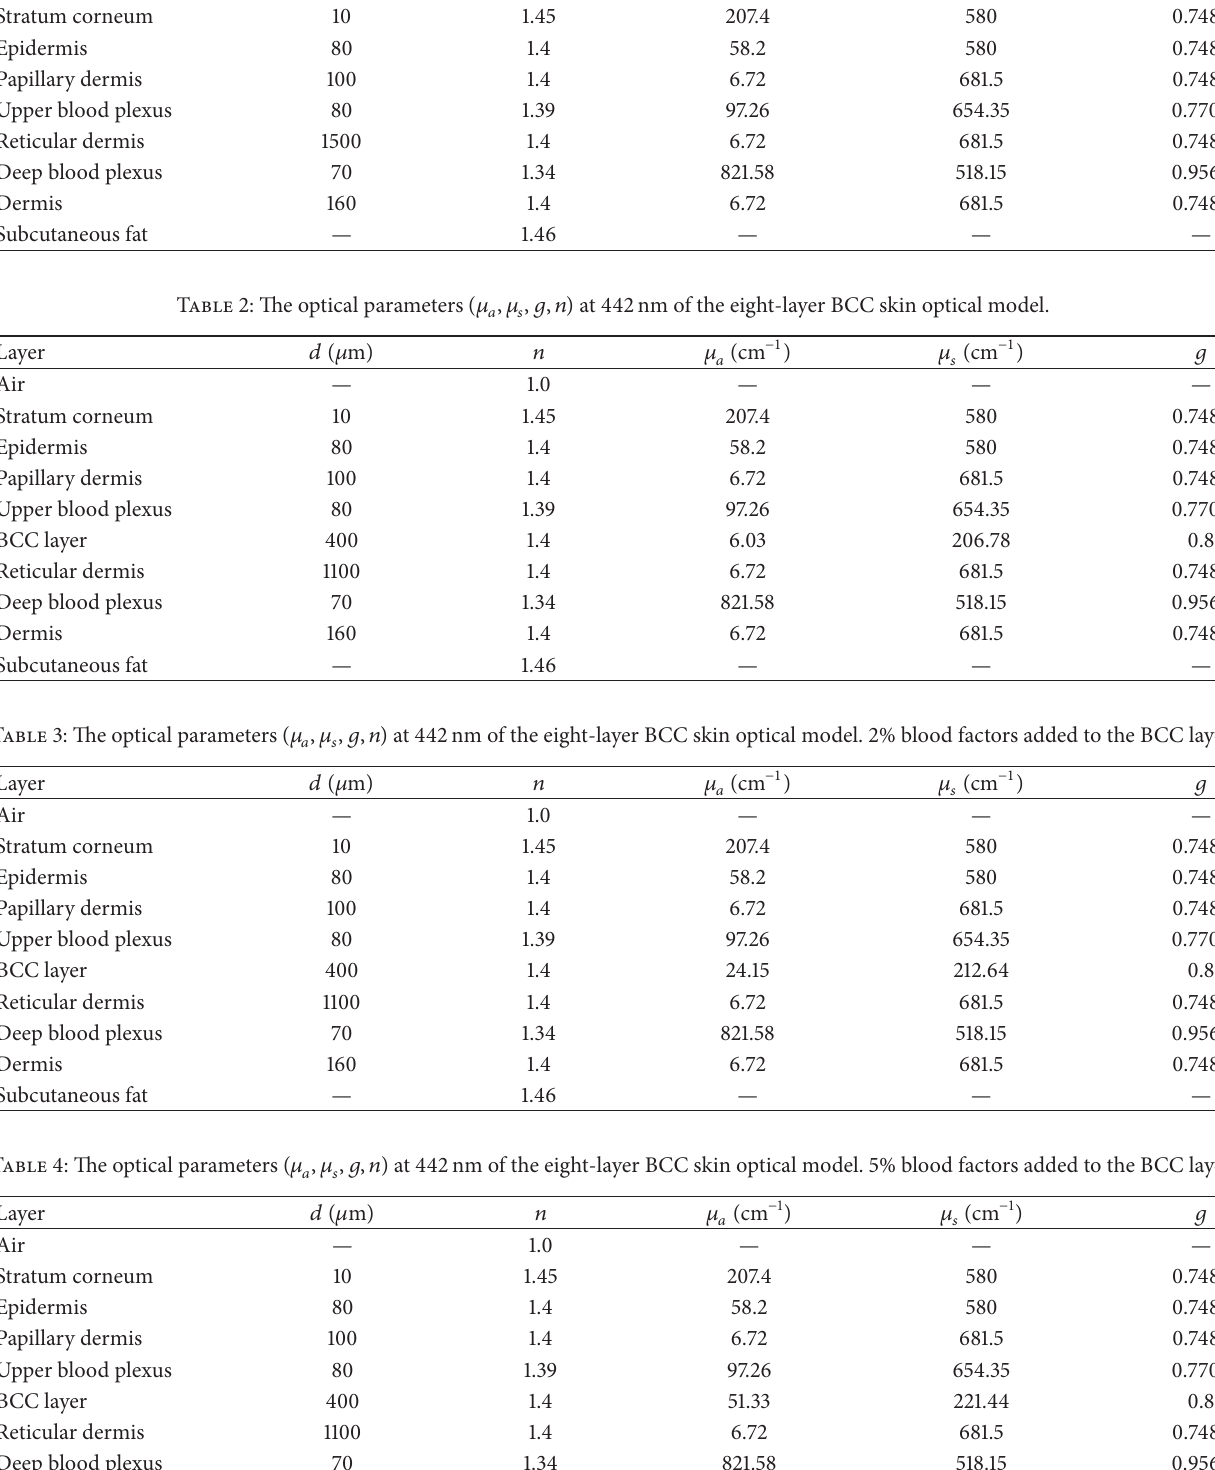
Table 1: The optical parameters ( 𝜇 𝑎 , 𝜇 𝑠 ,𝑔,𝑛 ) at 442nm of the seven-layer skin optical model. Layer Air —